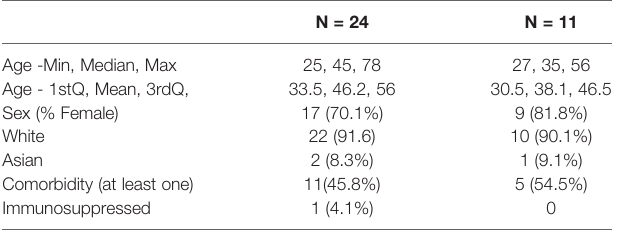
TABLE 1 | Demographics and clinical features of enrolled patients.